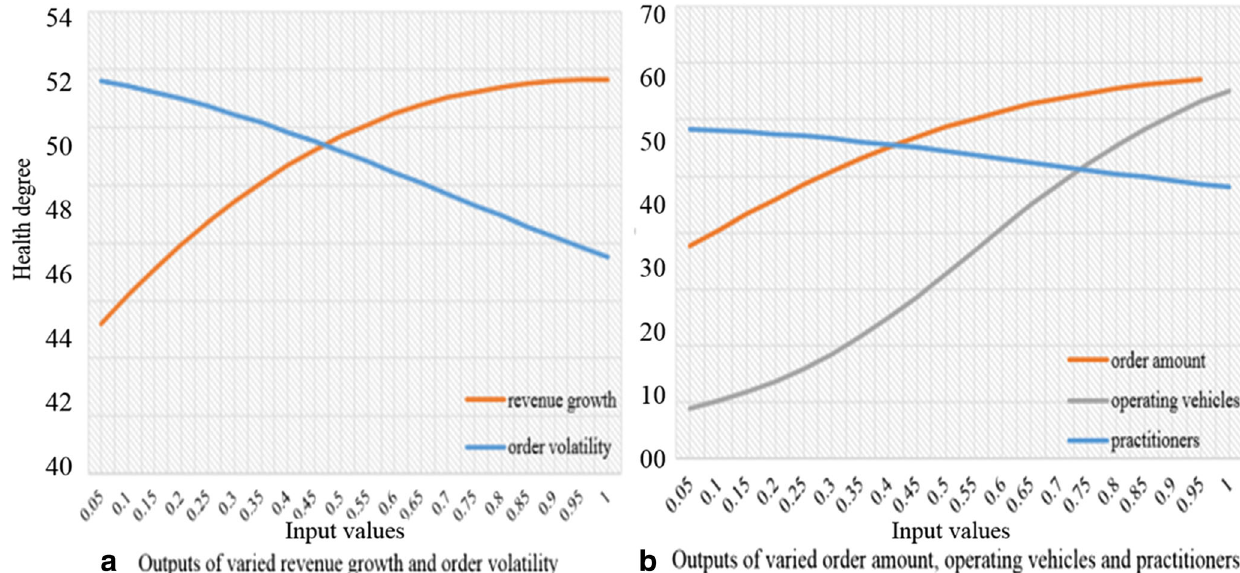
Fig. 9 Outputs of varied input of